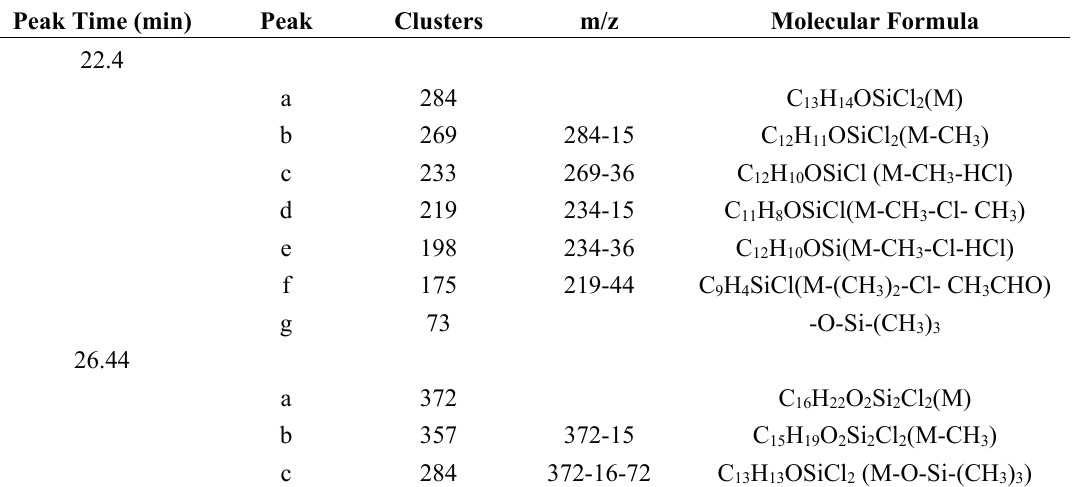
Table 1. Analysis of spectra peaked at 22.40 min and 26.44 min for two metabolites of 1,4-DCN.